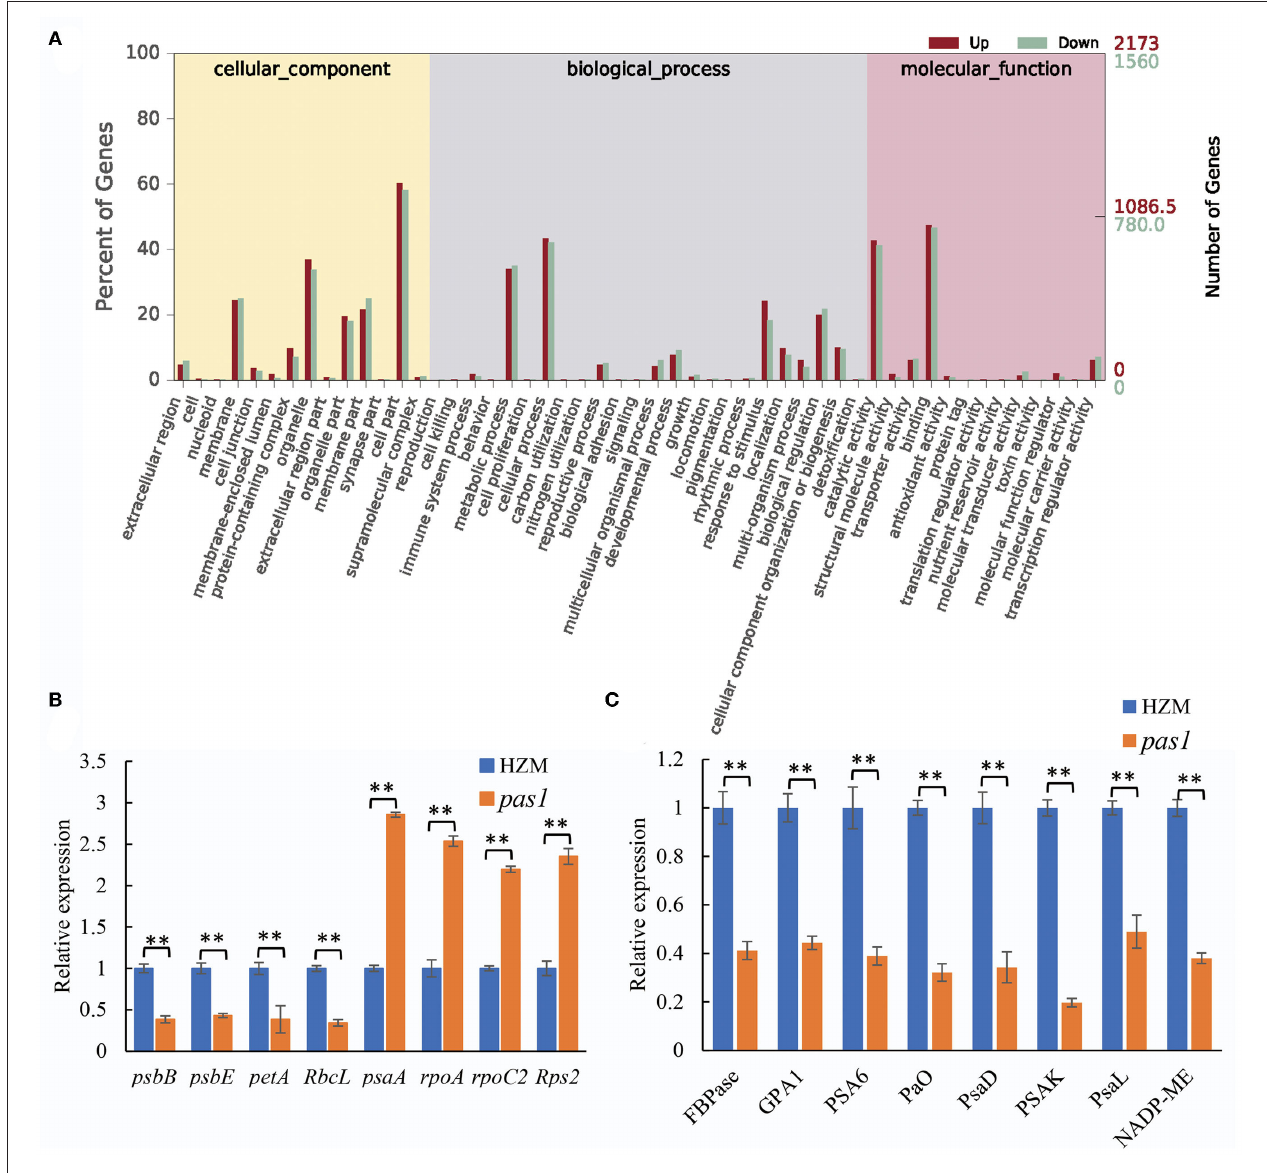
FIGURE 6 | Differentially expressed genes in pas1 mutant. The youngest leaves of seedlings at three-leaf stage were collected for the analyses. (A) , GO analysis of the DEGs from RNA-seq data between the wild-type and pas1 mutant. RNA-seqs were performed for three biological replicates, and DEGs were defined as fold change > 2 and p < 0.05. (B,C) , expression validation of some DEGs from RNA-seq data. The selected DEGs included chloroplast-coding (B) and nuclear-coding (C) genes. The expression of each gene was normalized to HZM and maize Actin gene served as internal control. “**” indicates p <